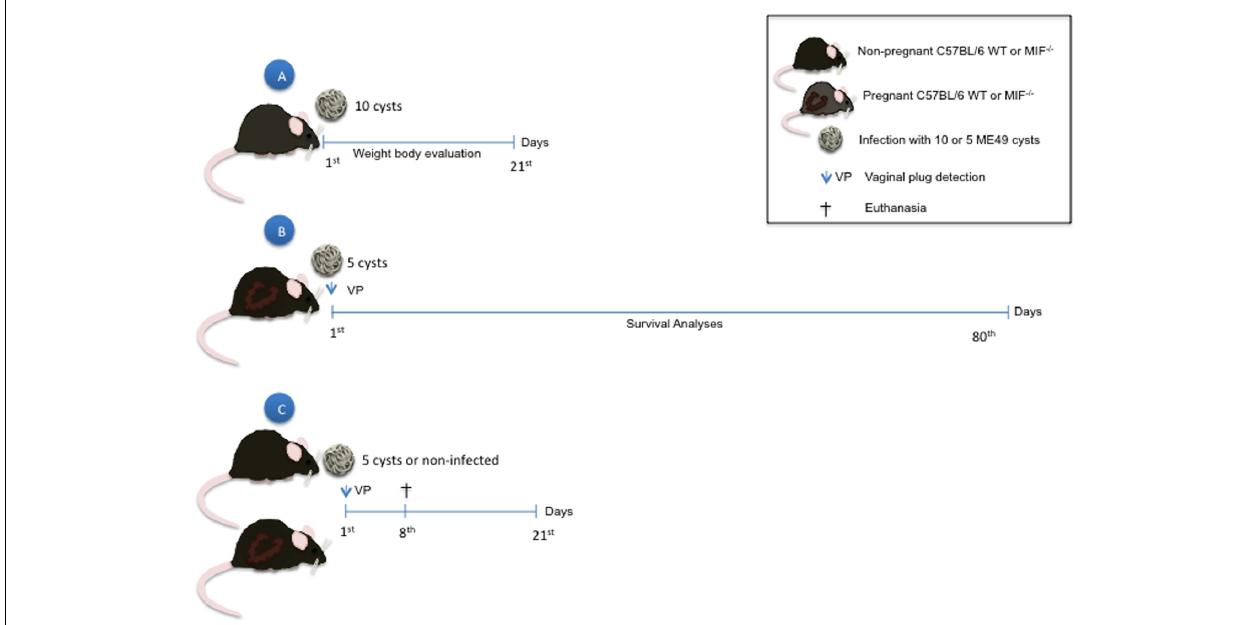
FIGURE 10 | Experimental design: (A) Non-pregnant mice from both genetic backgrounds (WT and MIF - / - ) were infected with 10 cysts of the ME-49 strain and were followed to verify the change in the body weight during 21 days. (B) Pregnant mice from both genetic backgrounds were infected with five cysts of the ME-49 strain on the day of detection of vaginal plug (vp), that is the first day of pregnancy (1st dop). Mice were followed during 80 days to survival analyses. (C) Pregnant and non-pregnant mice from both genetic backgrounds were infected with five cysts of the ME-49 strain on 1st dop. Animals were euthanized on day 8 post-infection. Blood sample was collected for cytokines analyzes. Liver, spleen and uterus were processed for parasitism analyses by PCR. Uteri have also been anatomically analyzed for evaluation of implantation sites (presence of reabsorption, hemorrhage and necrosis). Alternatively, uteri were used for cytokine measurements, protein analyzes by western blotting (IDO and CD74), histopathological evaluation and mast cell